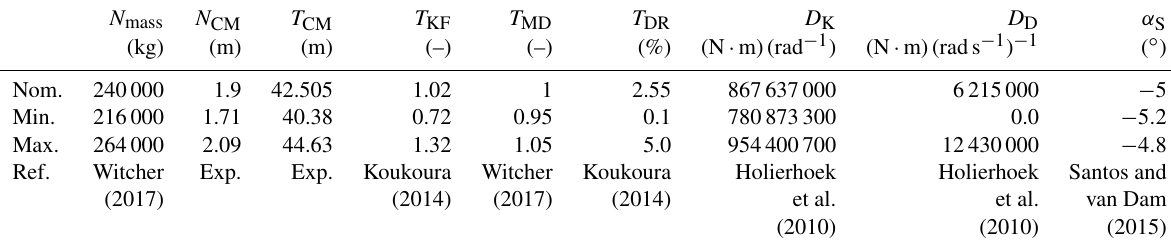
Table 7. Parameter value ranges of turbine support structure